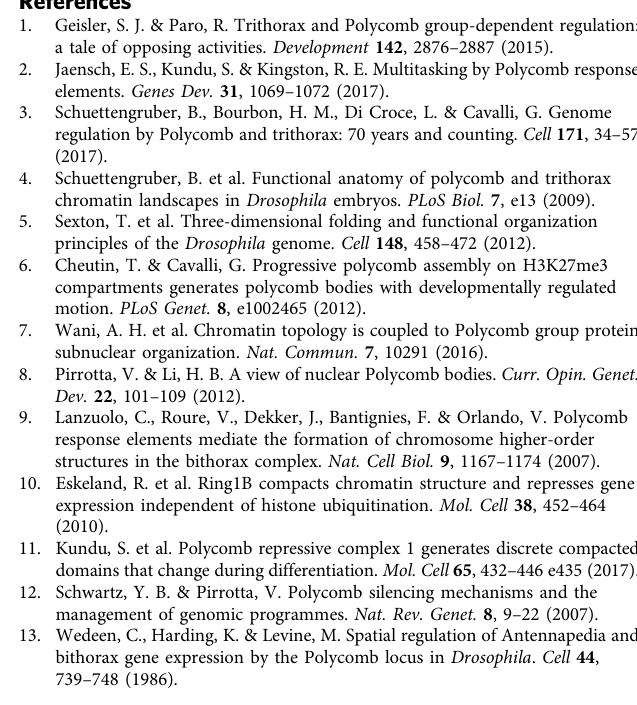
Fig. 5 cPRC1 only compacts chromatin in the repressed regions of the BX-C and ANT-C domains. a – f Box plots displaying distributions of the distances abdA – AbdB ( a , c ), Ubx – abdA ( b , d ), Scr – Antp ( e ), and lab – Scr ( f ) measured in the cell nuclei of Ph del embryos (red) and their respective controls (dark gray) or Pc XT109 embryos (green) and their respective controls (light gray). Measurements were made in PS9 – 12 ( a , b ), PS14 ( c , d ), and PS4 – 5 ( e , f ) during development. Distances distribution are comprised between 0 and 1.5 µ m. g , h Box plots presenting Pc ( g ) and Ph ( h ) enrichments at Scr and abdA FISH spots. Distribution of Pc and Ph enrichments are comprised between 0.2 and 11.33. The lower and upper bounds of the colored rectangles correspond to the fi rst and third quartiles, whereas the middle bars indicate the median distances ( a – h ). Signi fi cant differences are indicated (Mann – Whitney, U -test, two-tailed, * P < 0.05; ** P < 0.01; *** P < 0.001) ( a – h ). i , j Scatterplots showing correlations between the differential effect of Ph and Pc on the distance abdA – AbdB at 3:50 – 4:50 and the differential effect of Ph and Pc on abdA or AbdB expression at 4:50 – 6:00. Each point corresponds to one PS where abdA ( i ) or AbdB ( j ) are repressed in WT embryos. k Schematic diagram summarizing the effects of PRC1 on Hox gene folding and transcription. Circles represent silenced (OFF) or transcribed (ON) chromatin associated with Hox genes (red, open; purple, partly compact; blue fully compact). cPRC1 has no effect when Hox genes are expressed and chromatin is open. When Hox genes are repressed, cPRC1 compacts their chromatin during early embryogenesis and they will remain silenced. Without cPRC1, this compaction cannot occur and silenced Hox genes might become subsequently